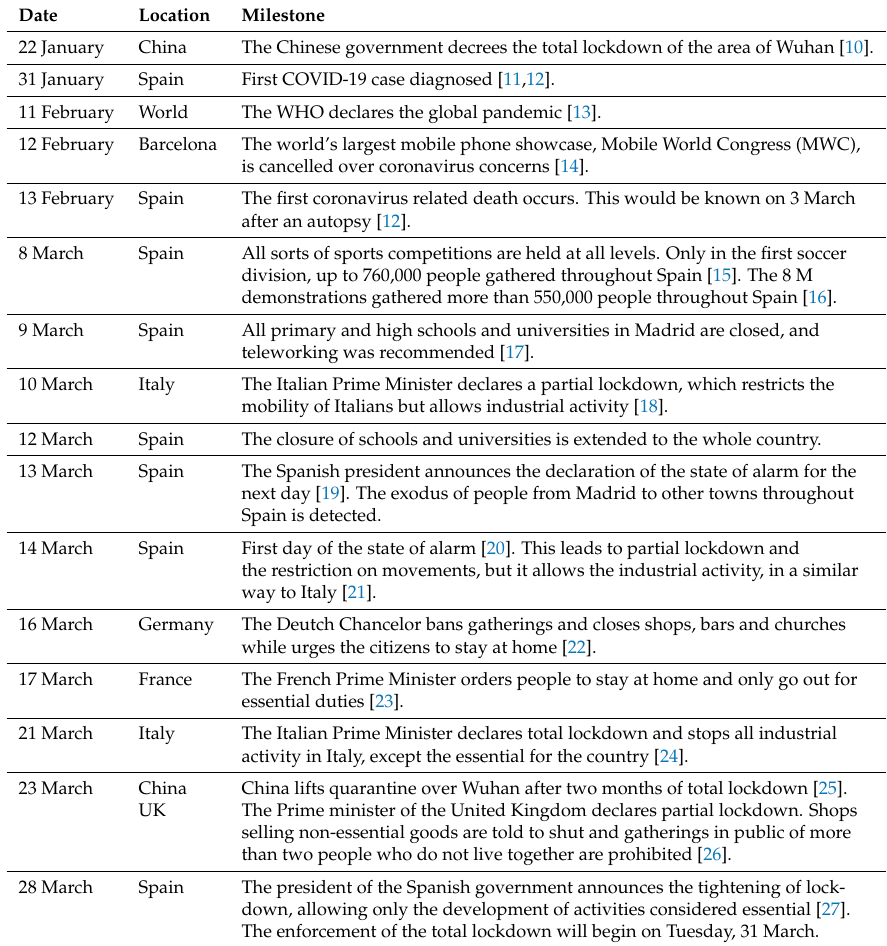
Table 1. Relevant